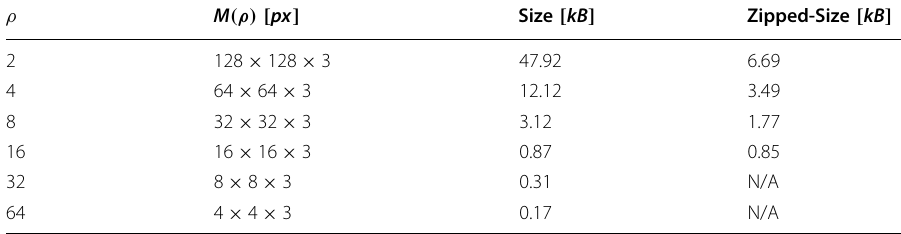
Table 1 Image size at CE output with and w/o